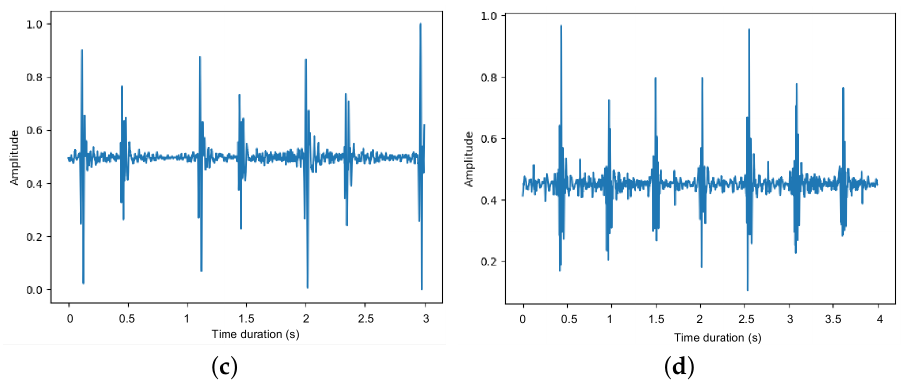
Figure 3. Time domain traces for various time durations: ( a ) 1 s, ( b ) 1.5 s, ( c ) 3 s, and ( d ) 4 s. The corresponding lengths of segment are ( a ) 2000, ( b ) 3000, ( c ) 6000, and ( d ) 8000 samples.